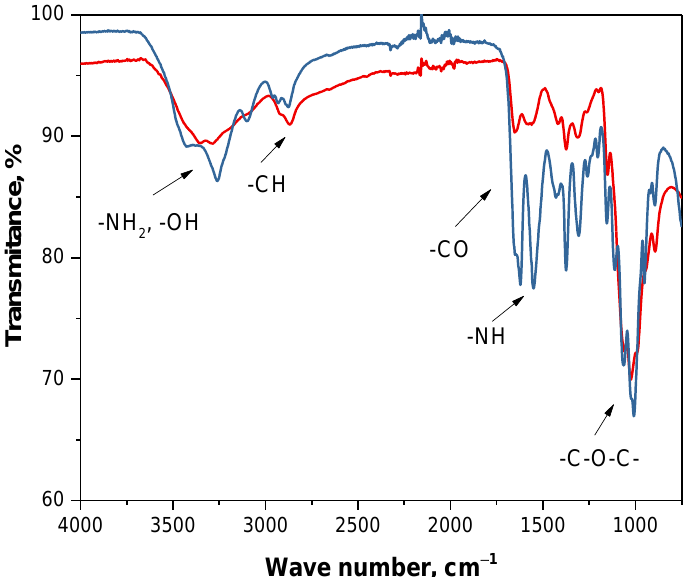
Figure 8. Comparison of FT-IR spectra of commercial chitosan (red) and sample after the whole processing (blue).